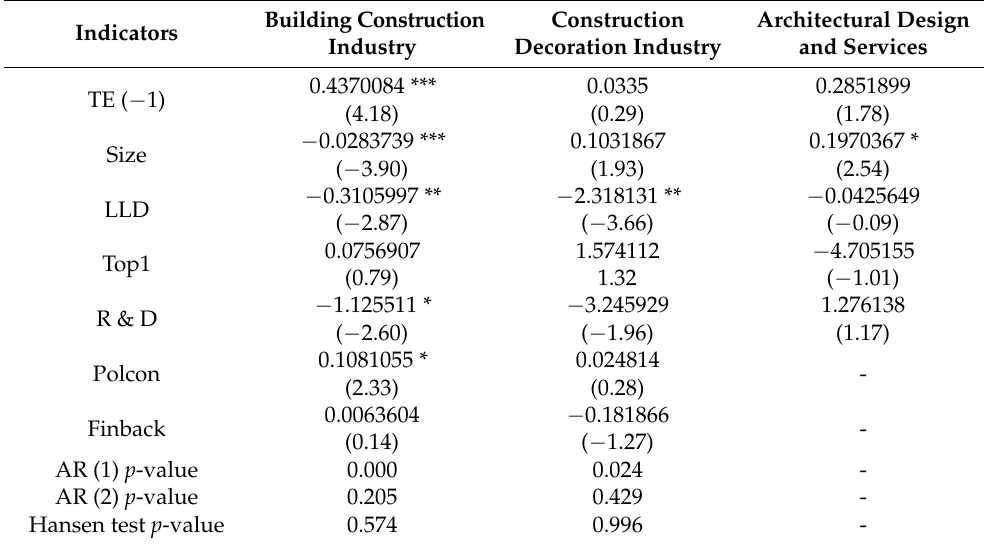
Table 11. Regression results of internal influencing factors of